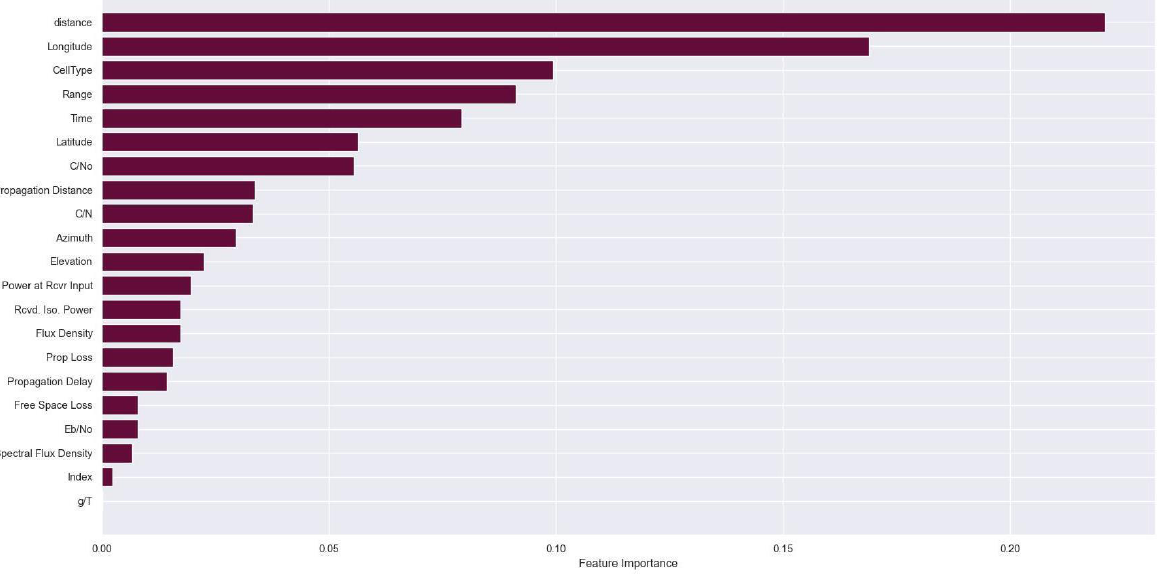
Figure 12. Feature